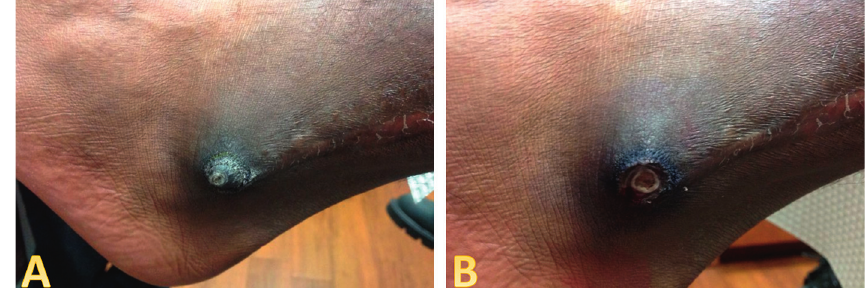
Figure 1: Initial clinic evaluation.1.6 × 1.6 cm irregular, hyperkeratotic, verrucous-appearing papule distributed on the left lateral malleolus. A surgical scar is visualized, running vertically on the lateral ankle superior to the lesion (a). A biopsy by shave was performed (b).